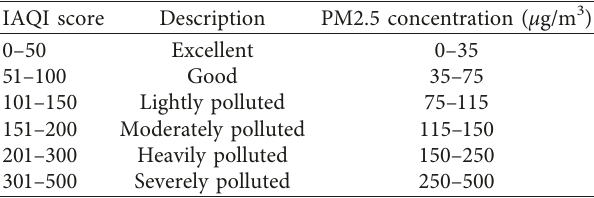
Table 17: PM2.5 AQI of mainland China. IAQI score